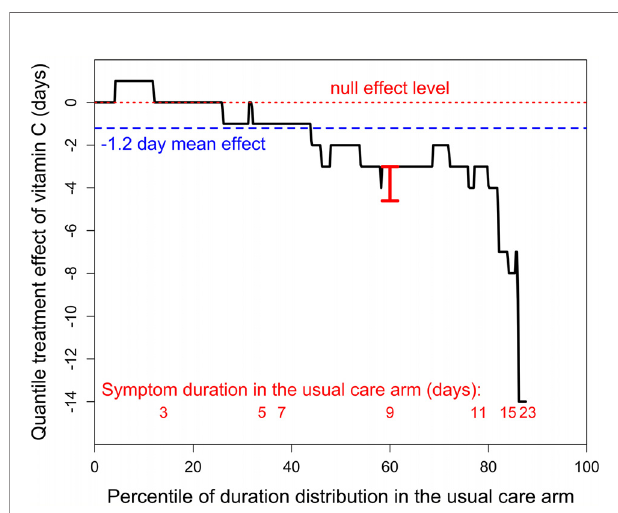
FIGURE 1 | The quantile treatment effect (QTE) of 8 g/day of vitamin C on the duration of symptoms in outpatient cases of SARS-CoV-2 infection. The horizontal axis shows the distribution of the duration by percentiles. The black stepped line indicates the QTE of vitamin C. The horizontal red dotted line indicates the null effect. The blue dashed line shows the 1.2-day mean effect of vitamin C. The red vertical bar at the 60 th percentile indicates the 95% CI (-4.61 to -3 days; t = 7.3 P = 10 -10 ), calculated with the fi t.crq procedure of the R-statistical software (15 – 17). The red numbers at the bottom indicate the lowest percentile level for the odd number of days of duration of SARS-CoV-2 infection in the usual care arm. For example, 9-10 day infections cover the percentile range from 58 th to 76 th , which corresponds to 9 patients, as the total number of usual care patients was 50. The QTE curve is stopped at the 88 th percentile since 6 patients inthe usualcare group were censored, i.e., did not recover bythe end of the follow-up. See extracted datain Table S1 , and our calculationsand the redrawnrecoverycurve inthe Supplementary File